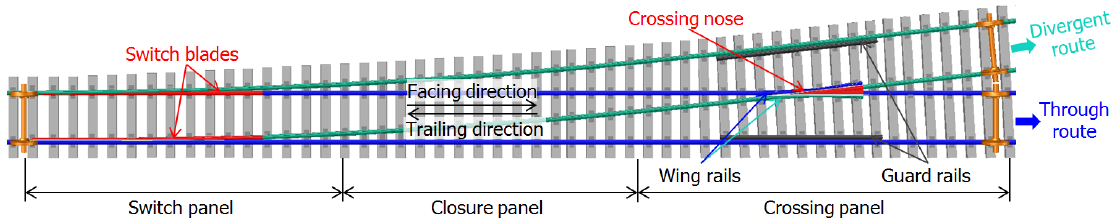
Figure 1. Standard left-hand railway turnout and the definition of the passing routes.